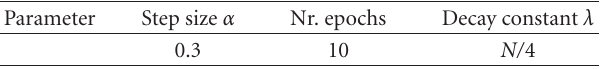
Table 1: Optimal parameter combination for the “neural-gas” network optimized for data set #1 when choosing N = 4